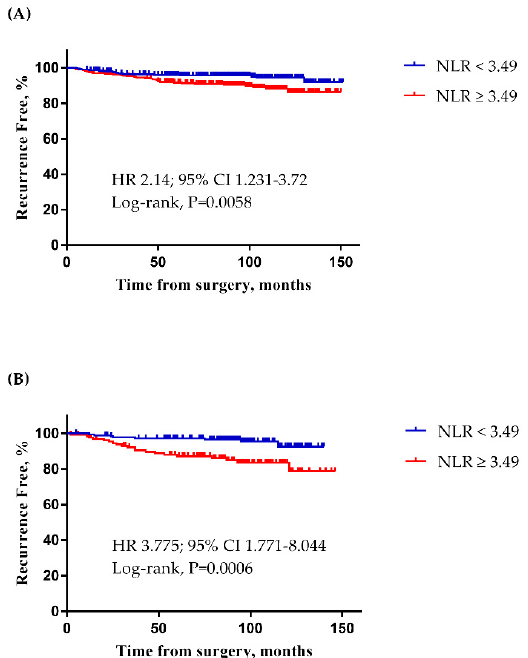
Figure 1. Kaplan-Meier survival curve of the neutrophil-to-lymphocyte ratio (NLR) cut-o ff point. ( A ) When the NLR cut-o ff point was 3.49 in the training set ( n = 731), patients with high NLR showed lower recurrence-free survival (RFS; HR 2.14; 95% CI 1.231–3.72, p = 0.0058). ( B ) When the NLR cut-o ff point was 3.49 in the validation set ( n = 313), patients with high NLR showed lower RFS (HR 3.775; 95% CI 1.771–8.044, p =